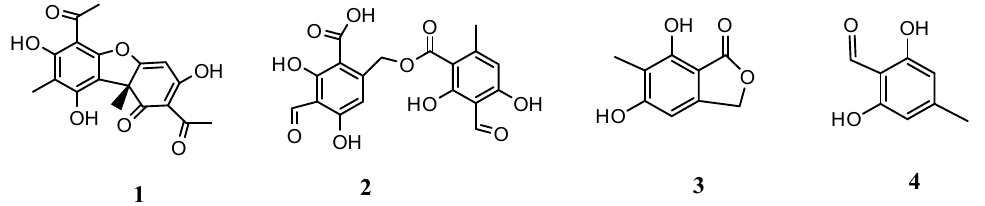
Figure 2. Compounds isolated from H. lugubris (Usnic acid, 1 ; barbatolic acid, 2 ; 5,7-dihydroxy-6- methylphthalide, 3 ; and atranol, 4 ).